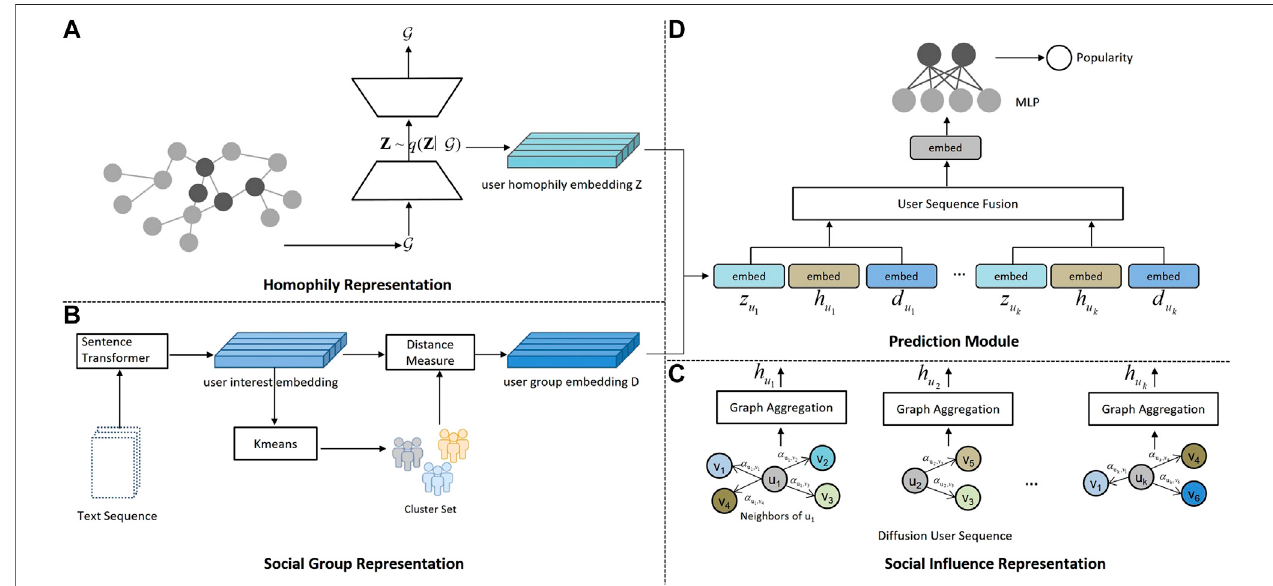
FIGURE 1 | Proposed framework for the popularity prediction